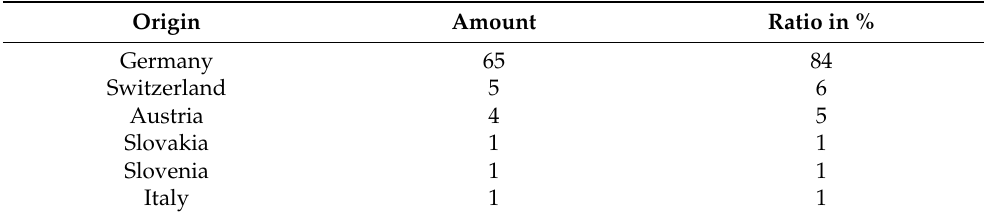
Table 4. Demographics of survey attendances, category Europe